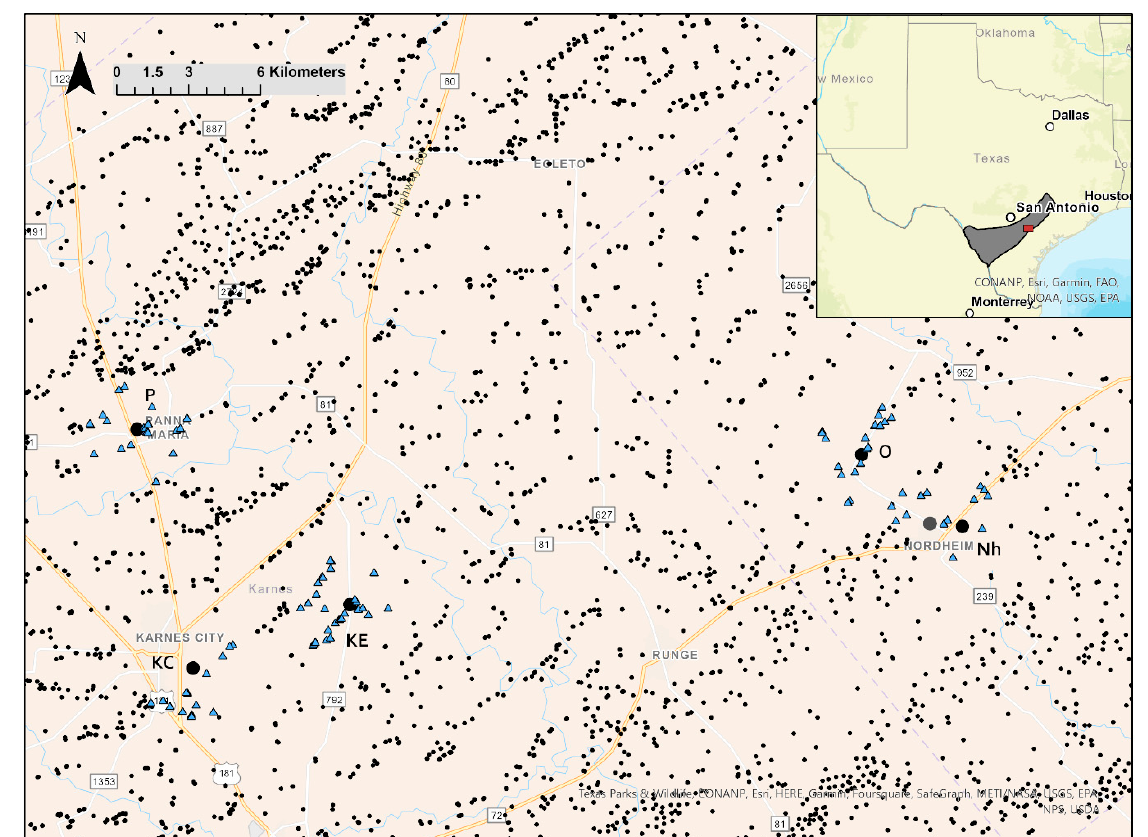
Figure 2. Map of the investigation area in the Eagle Ford shale. Deployment sites (east to west: Nordheim—Nh, Osterloh—O, Karnes East—KE, Karnes City—KC, Panna Maria—P) are depicted as larger black dots; actively producing wells as small black dots; and wells linked to surface pads within 2 km of each sampling site as blue triangles. The old Nordheim site is depicted as a grey dot. The inset shows a map of Texas with an outline of the Eagle Ford Shale area (in grey) and the study region highlighted by a red rectangle southeast of San Antonio. Figure created in ArcGIS using “World Navigation Map” with inputs from Esri, HERE, Garmin, FAO, NOAA, USGS, © OpenStreetMap contributors, and the GIS User Community. Well data used in the map are freely available from the Railroad Commission of Texas (RRC) at https://www.rrc.texas.gov (accessed on 11 April 2023).